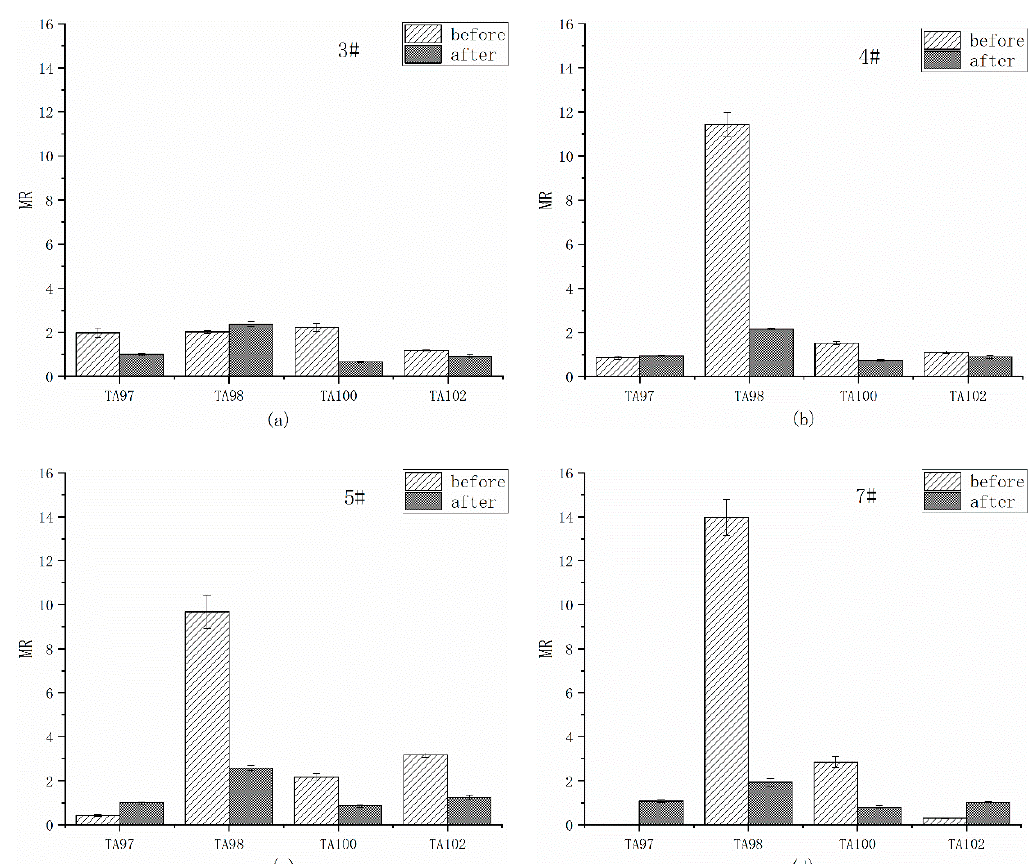
Figure 2. Mutagenesis of four strains by overlying water before and after remediation in the absence of liver microsomal S9; ( a ) site 3#; ( b ) site 4#; ( c ) site 5#; ( d ) site 7#. The mutagenicity ratio (MR) is the average ratio from 3 independent experiments.